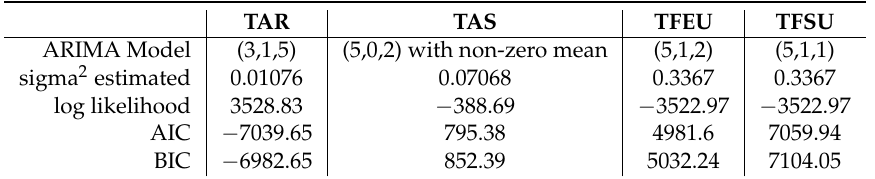
Table 4. Estimated ARIMA